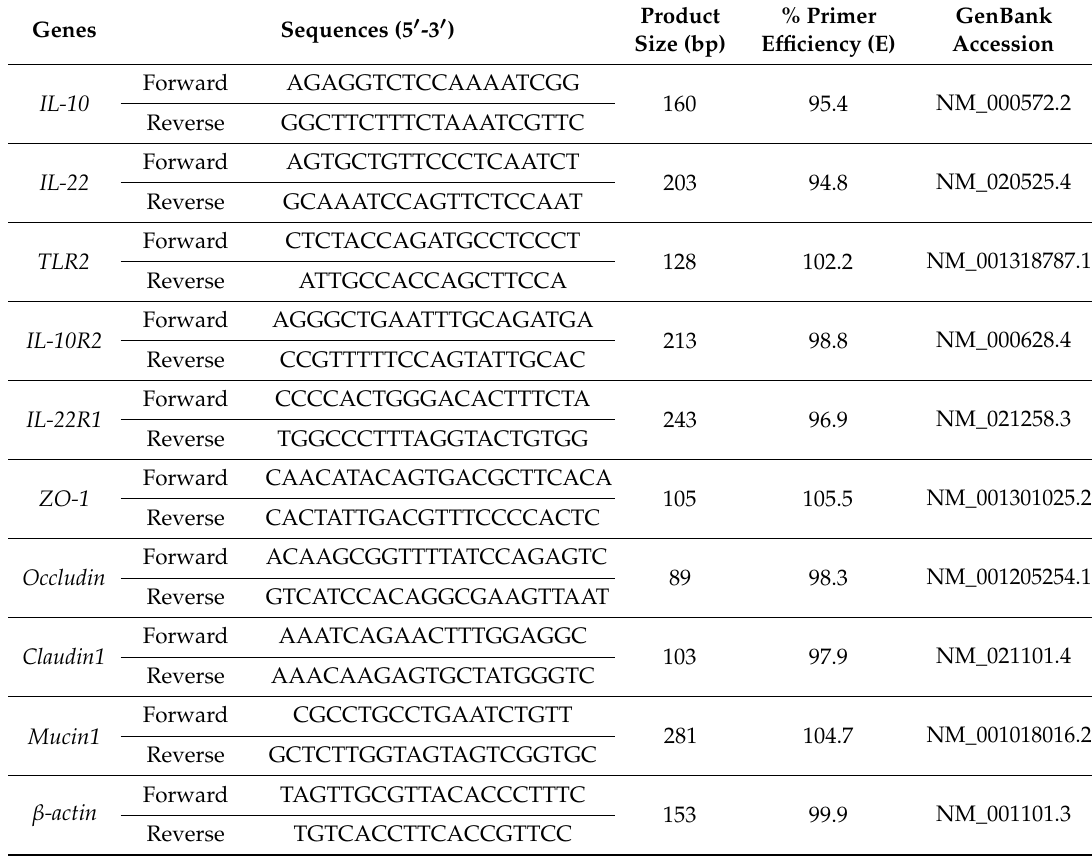
Table 1. Primer Sequences Used in this